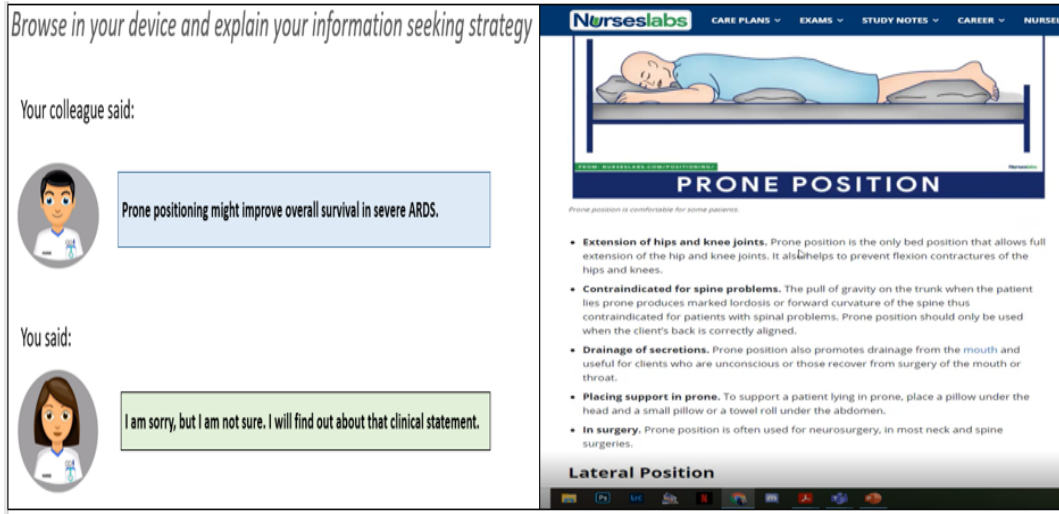
Figure 2. TA session.